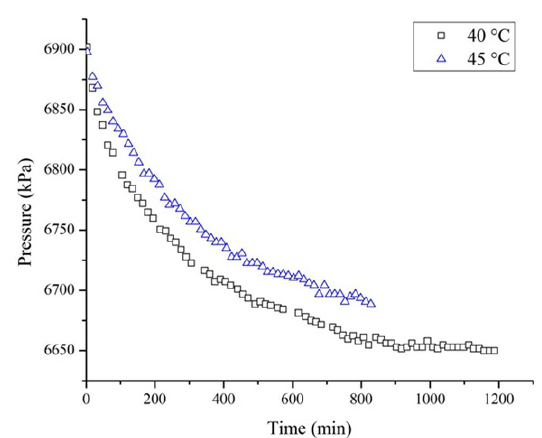
n o √ P ( t ) Figure 5. erfc − 1 versus t in 40 ◦ C and 5900 kPa initial Pt pressure.